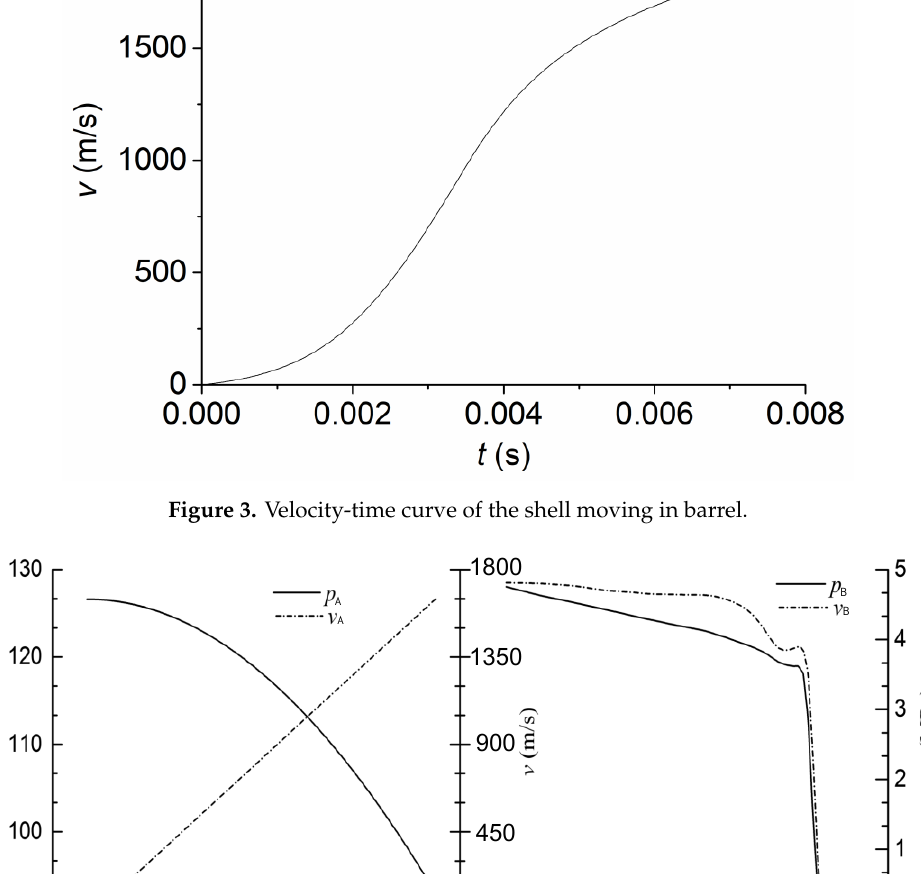
( b ) Numerical result Figure 5. Comparison of numerical and experimental interferograms in the shock-tube experiment. Secondly, a computational model similar to the present work (barrel not considered) was used to simulate the horizontal flight of a projectile at M a = 3.6. The numerical results are compared to experimental results in the literature [22] as shown in Figure 6. The left side of the figure shows the experimental results, and the right side shows the present numerical results. Good consistency between the numerical results and the experimental ones can be observed in the figure. Therefore, the dynamic mesh and boundary conditions are validated.